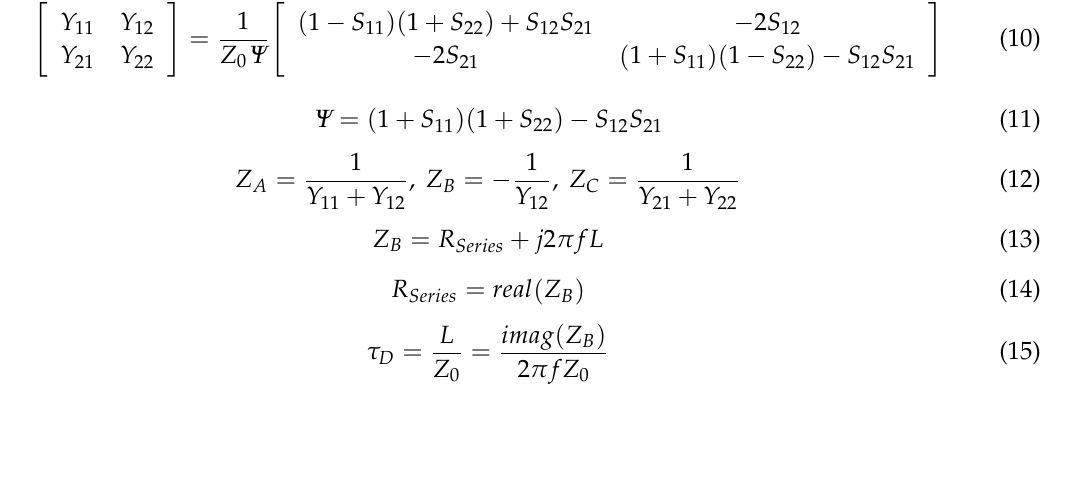
Figure 5. S-parameter phase of the 6 dB attenuator (Weinschel ® 75A-06, Weinschel, Frederick, MD, USA).